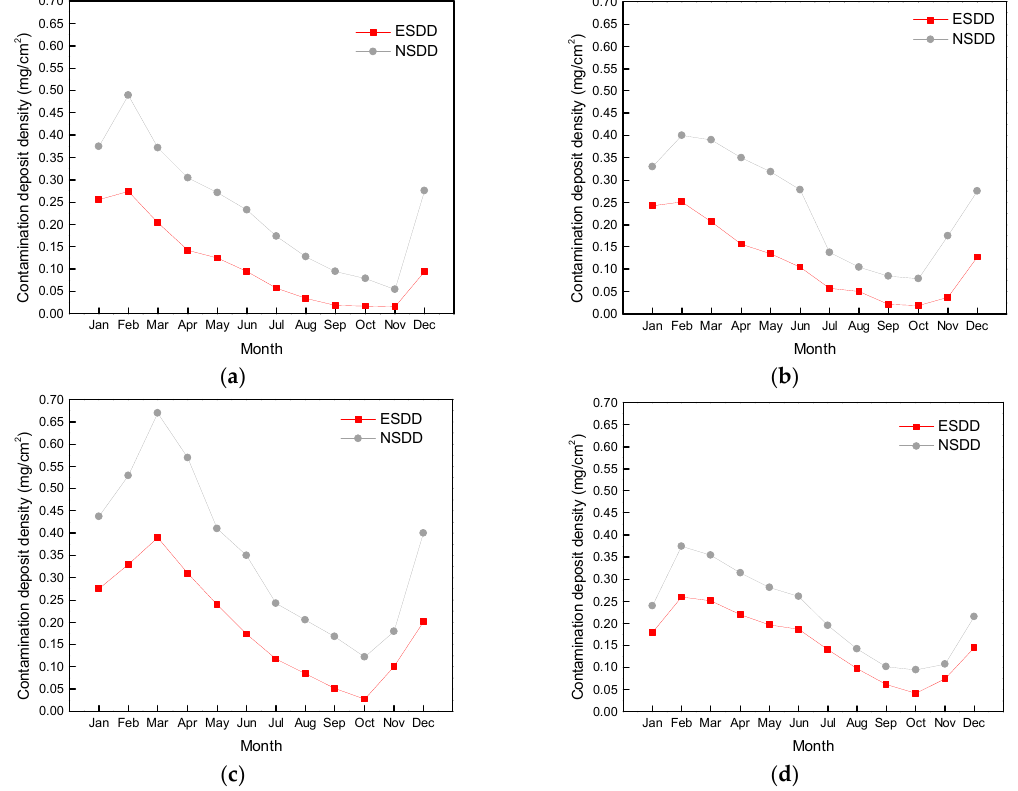
Figure 6. The contamination deposit densities for 2014 in different test sites: ( a ) He-Yun (Transportation); ( b ) Xing-Yun (Local agricultural); ( c ) Chuan-Gu (Industrial) and ( d ) Gu-Xing (Mountainous region).